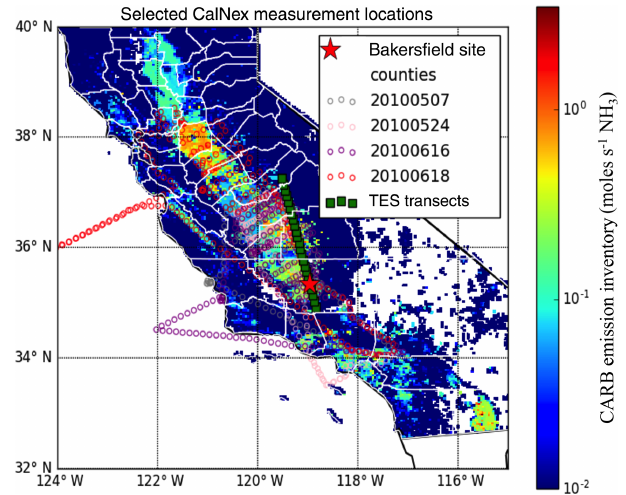
Figure 1. Distribution of NH 3 emissions across California (back- ground) on 12 May 2010 at 19:00UTC as well as P3 flight tracks (small circles), TES transect (green squares), and the Bakersfield site (red star) with the county lines shown in